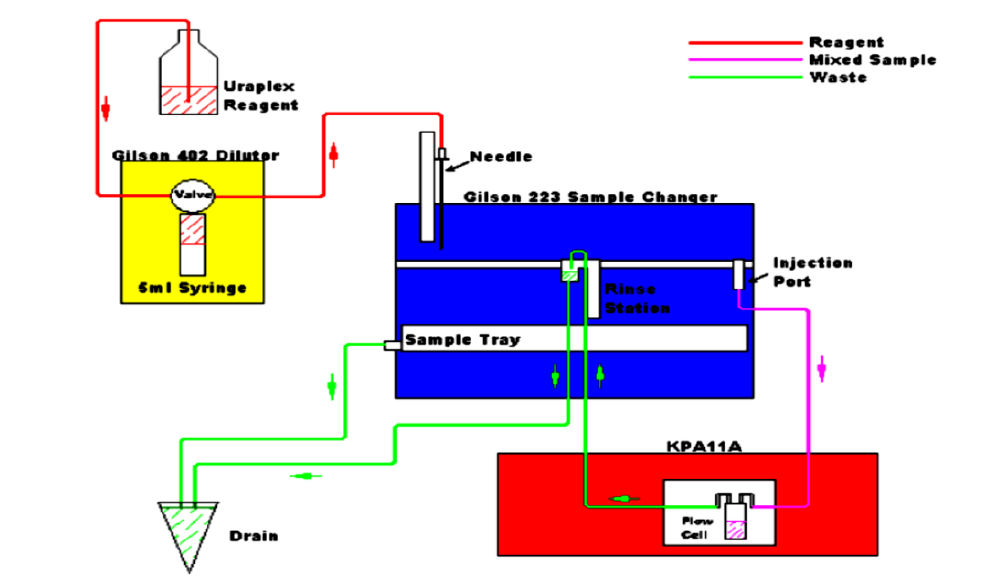
Fig. 1: Tubing diagram of the kinetic phosphorescence analyzer [10].